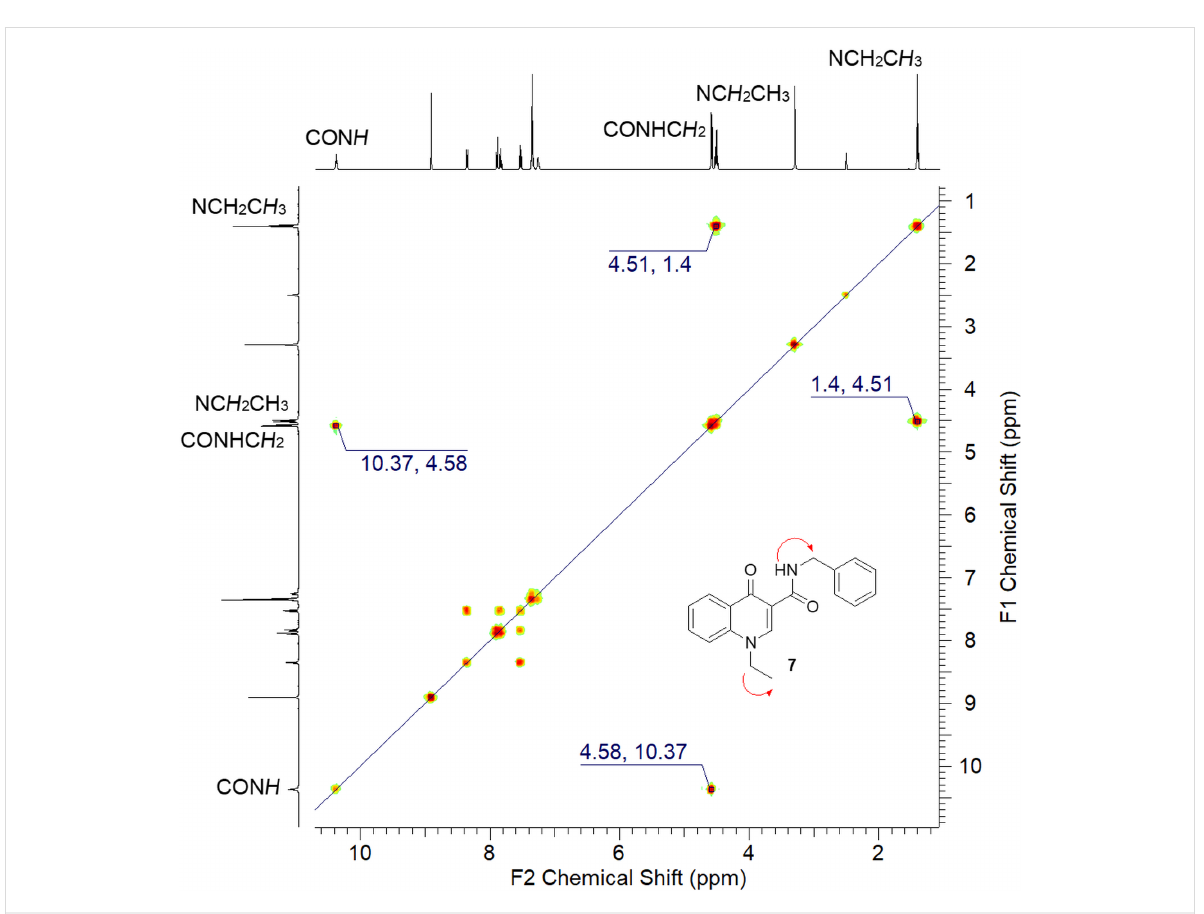
Figure 4: 1 H, 1 H-COSY spectrum of derivative 7 (DMSO- d 6 , 500